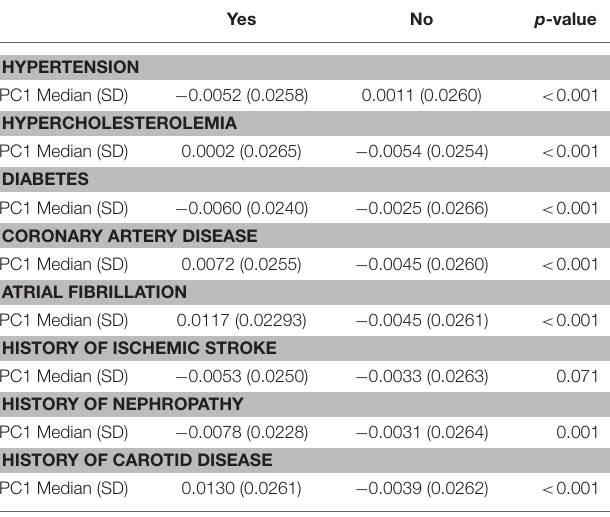
TABLE 3 | PCs differentiate those affected from those unaffected by VRFs, within each self-identified race/ethnicity group. PC Yes